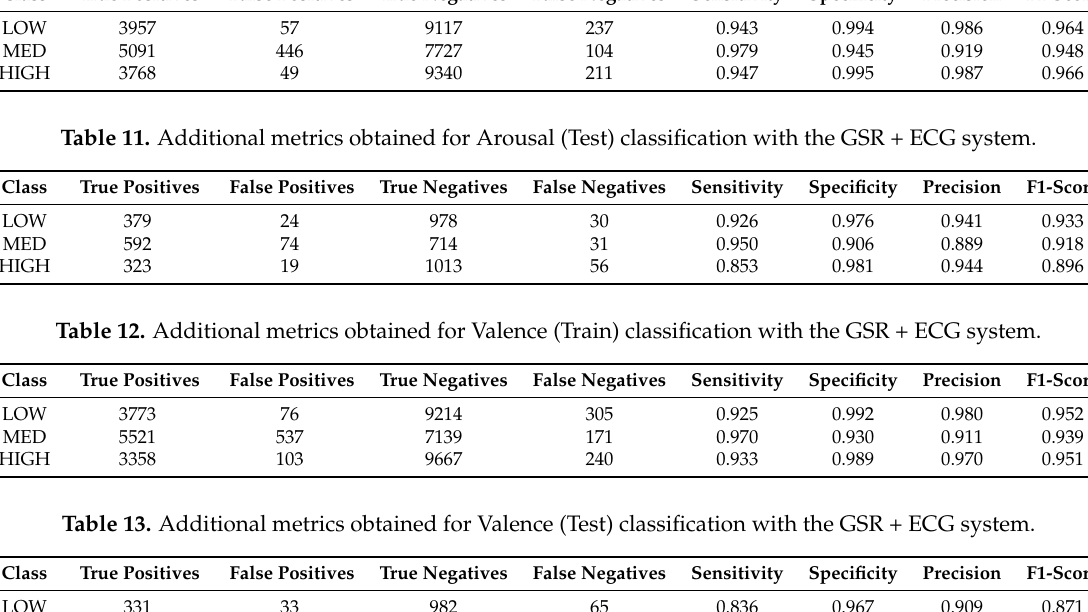
Table 10. Additional metrics obtained for Arousal (Train) classification with GSR + ECG system. Class